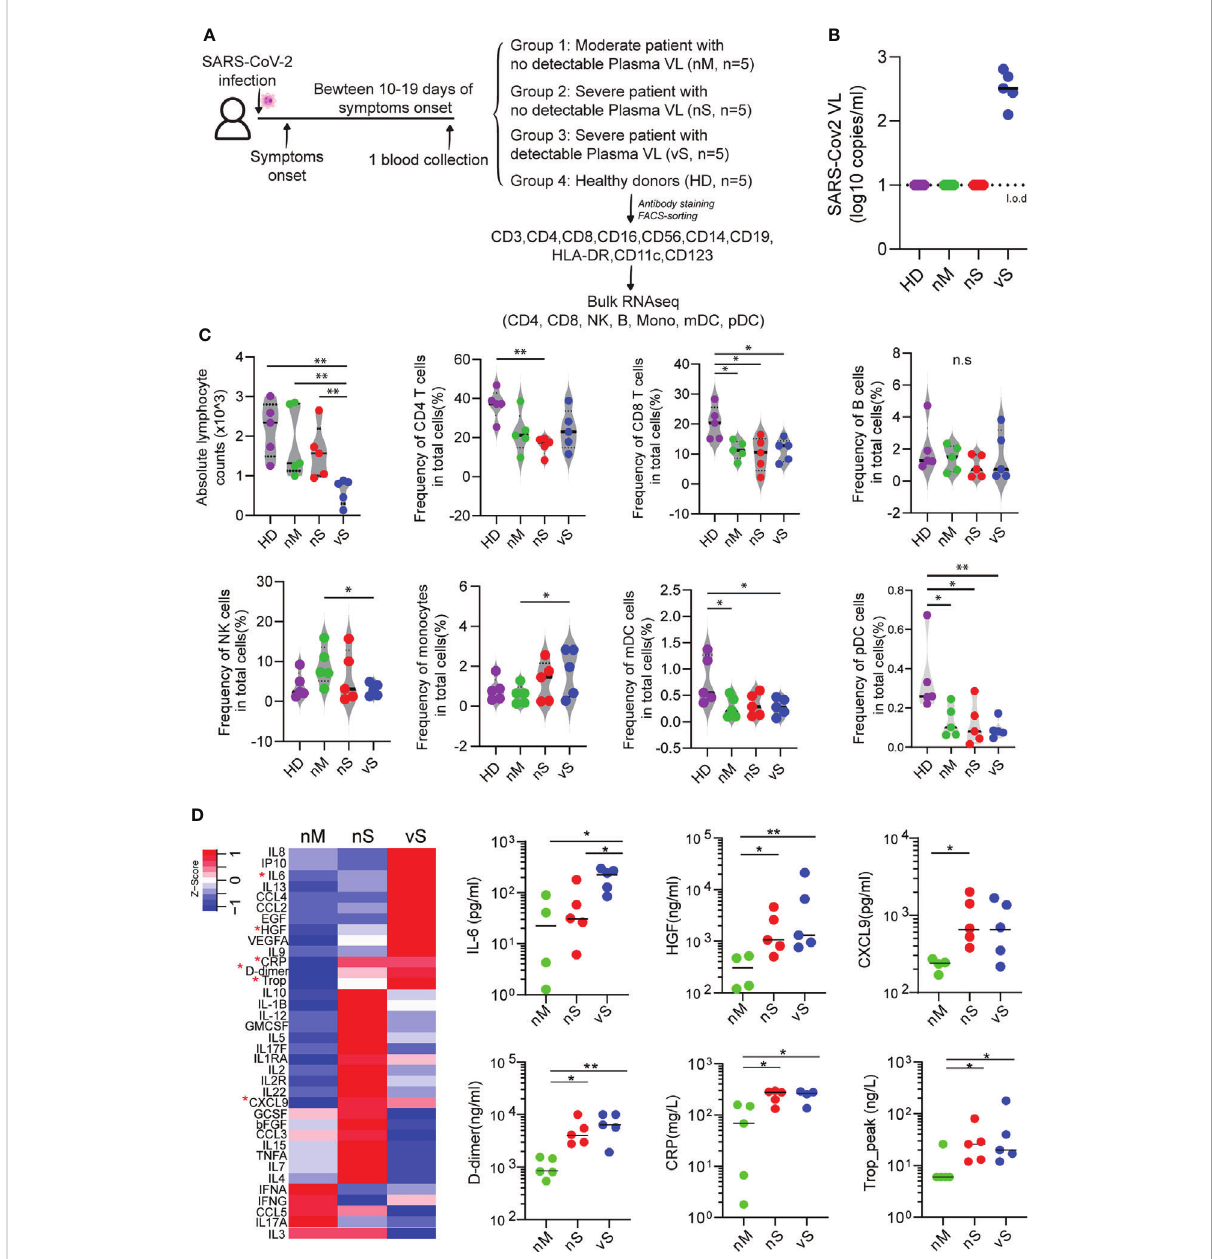
FIGURE 1 Cell frequency and cytokines changes observed in participants with different disease severity. (A) Overview of experimental design. PBMCs from three groups of COVID-19 patients with moderate (nM, n=5), a severe disease without detectable plasma viral load (nS, n=5), severe disease with detectable plasma viral load (vS, n=5), and healthy donors (HD, n=5) were collected. Seven major cell types were sorted and subjected to bulk RNAseq. (B) Levels of SARS-CoV-2 plasma viral loads were measured by qRT-PCR and the dashed line indicated the limit of detection (l.o.d). (C) Violin plots of 7 major cell lineage composition in PBMCs from the nM, nS, vS, and HD groups by fl ow cytometry analysis. (D) Heat map showed secretion level of 36 cytokines in plasma from different study groups, and any group that shows statistical signi fi cance were highlighted in red star and also shown in the dot plot. A p-value was calculated by the Kruskal-Wallis test. *: p < 0.05, **: p < 0.01, n.s., not signi fi